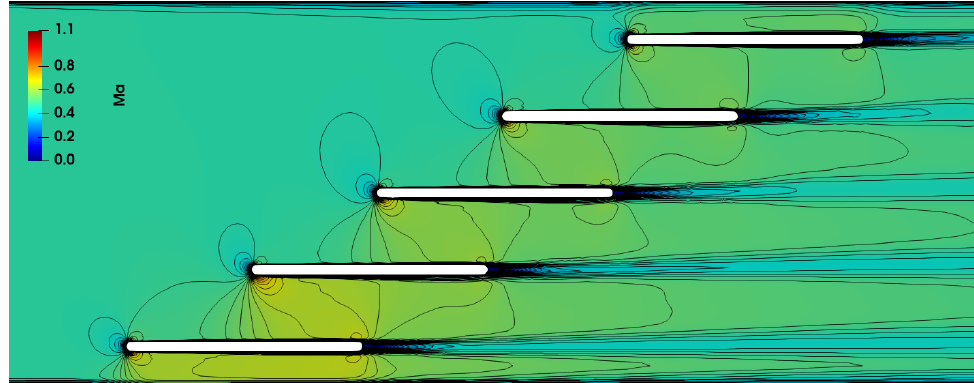
Figure 11. Distribution of the Mach number in the domain, M 2 is = 0.5, α = 0°.